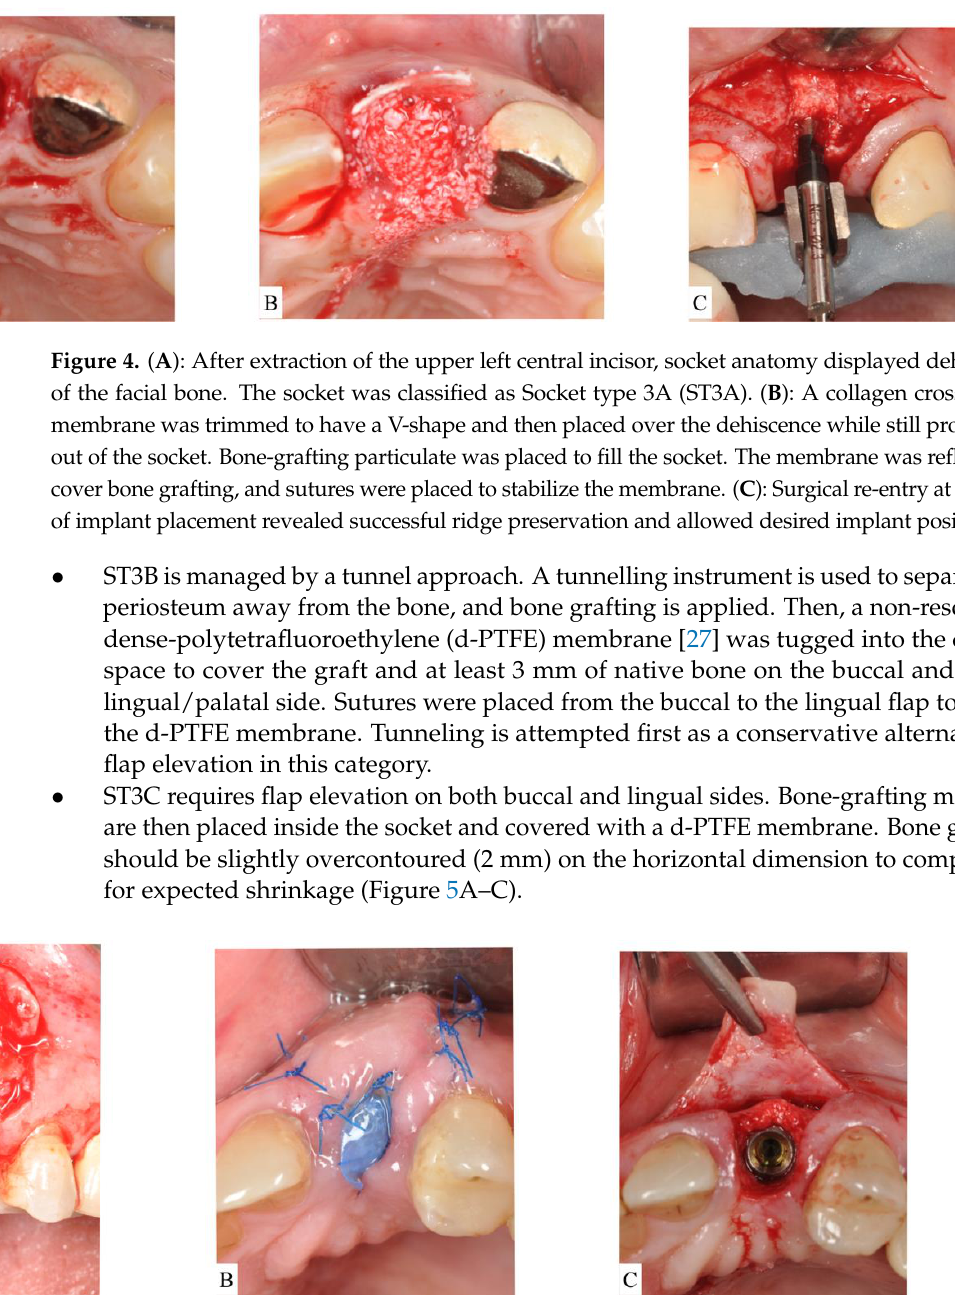
Figure 5 . ( A ): Flap reflection apical to the upper left unrestorable maxillary canine showed visible dehiscence of the facial bone. The socket was classified as Socket type 3C (ST3C). ( B ): A d-PTFE membrane is placed to cover the particulate bone. The flap is sutured without attempting primary closure. ( C ): Surgical re-entry at the time of implant placement showed adequate bone volume for installation of an implant fixture in a restorable